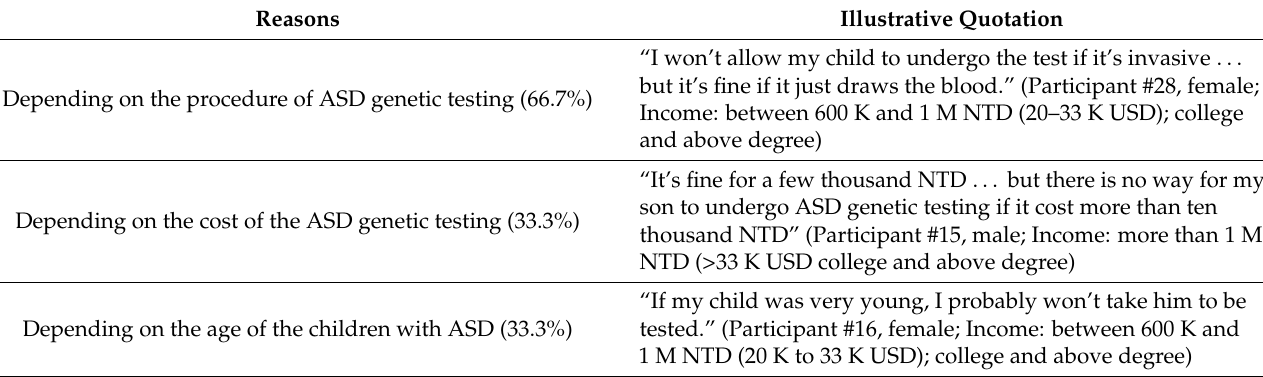
Table 3. Reasons for being unsure about whether to pursue ASD genetic testing among parents of children with